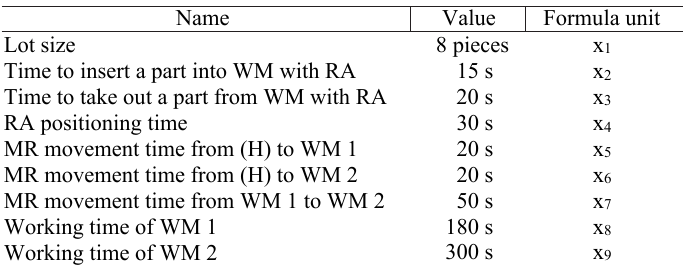
Table 1. Input data for mathematical